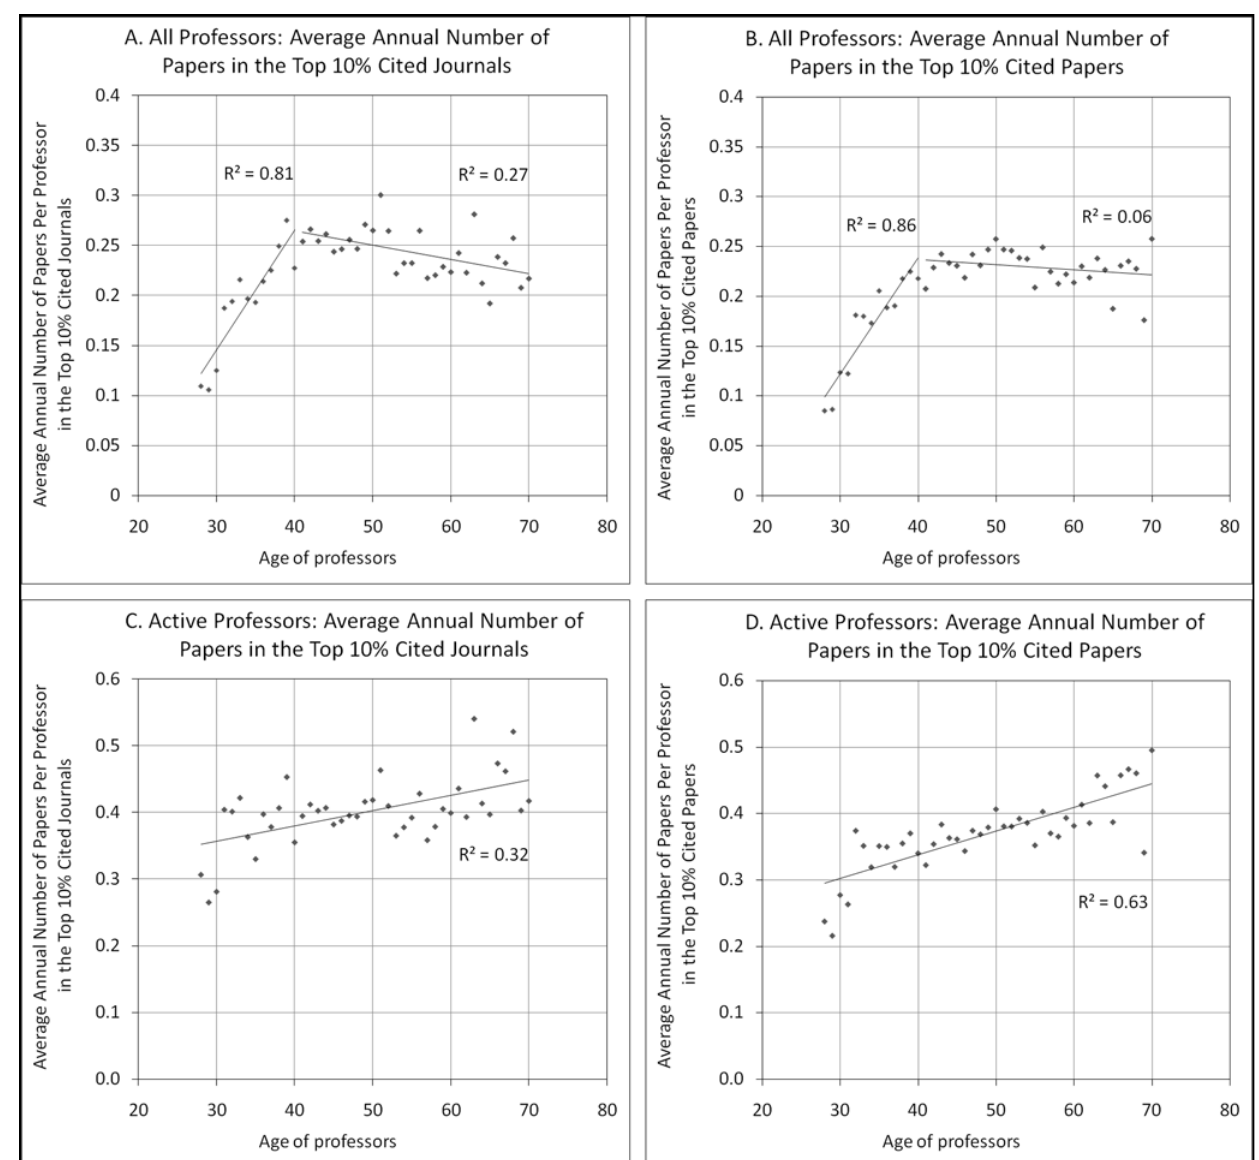
Figure 5. Distribution of highest impact papers by professor age. A) Average annual number of papers per professor in the top 10% cited journals ( all professors ) B) Average annual number of papers per professor in the top 10% cited papers ( all professors ) C) Average annual number of papers per professor in the top 10% cited journals ( active professors ) D) Average annual number of papers per professor in the top 10% cited papers ( active professors